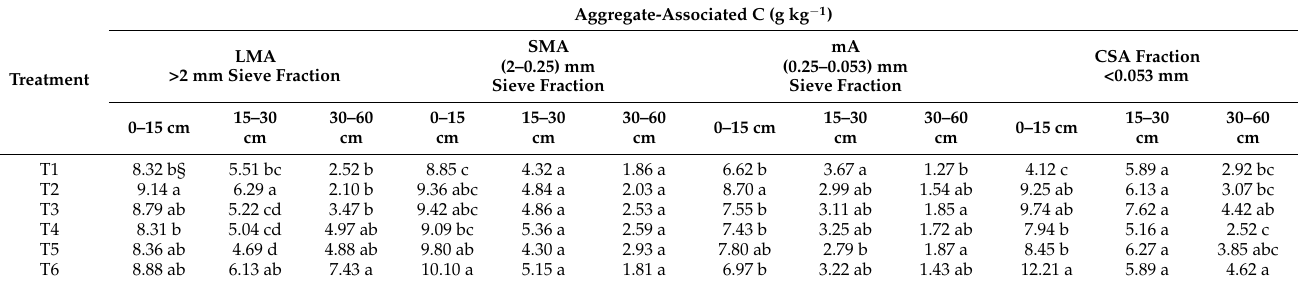
Table 3. Effect of organic manures and biofertilizers on aggregate-associated C for large macroaggre- gate (LMA, >2 mm), small macroaggregate (SMA, 2.0–0.25 mm), microaggregate (mA, 0.25–0.053 mm) and (silt + clay) CSA sieve under rice–wheat cropping